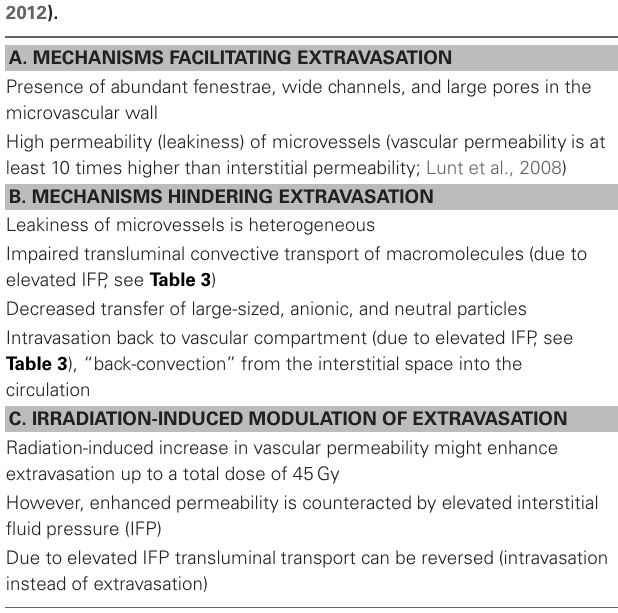
Table 1 | Obstacles in blood-borne delivery of macromolecular anticancer and diagnostic agents and modulations following irradiation (selection; Vaupel, 2006, 2009a).